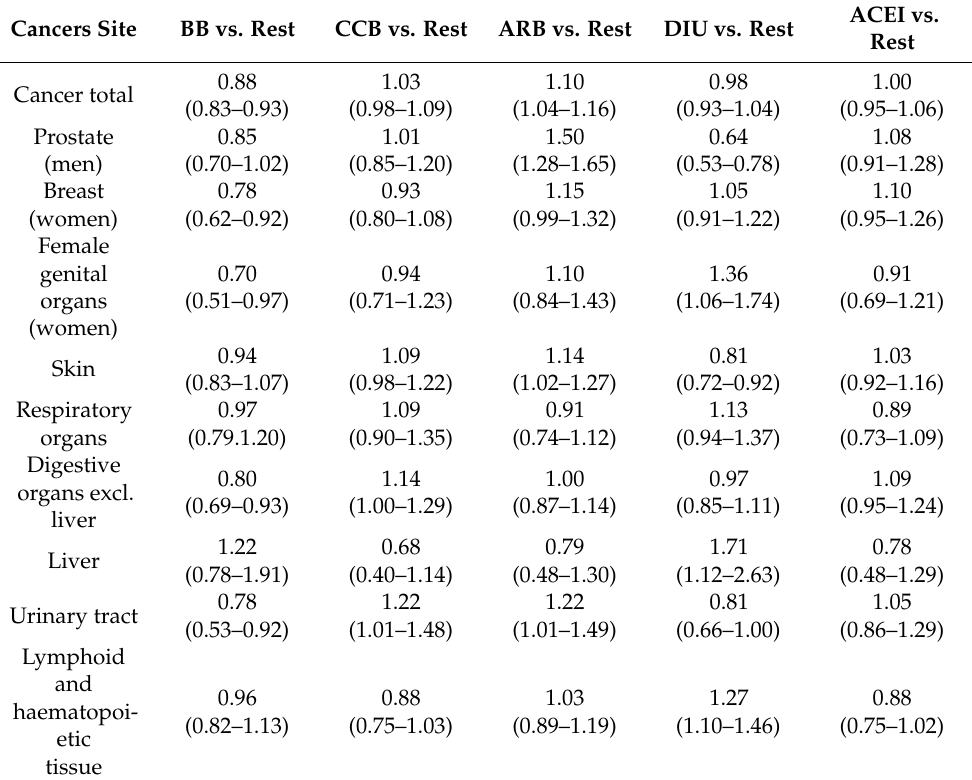
Table 2. Association between antihypertensive therapy and the incidence of cancer (Cox regression models).